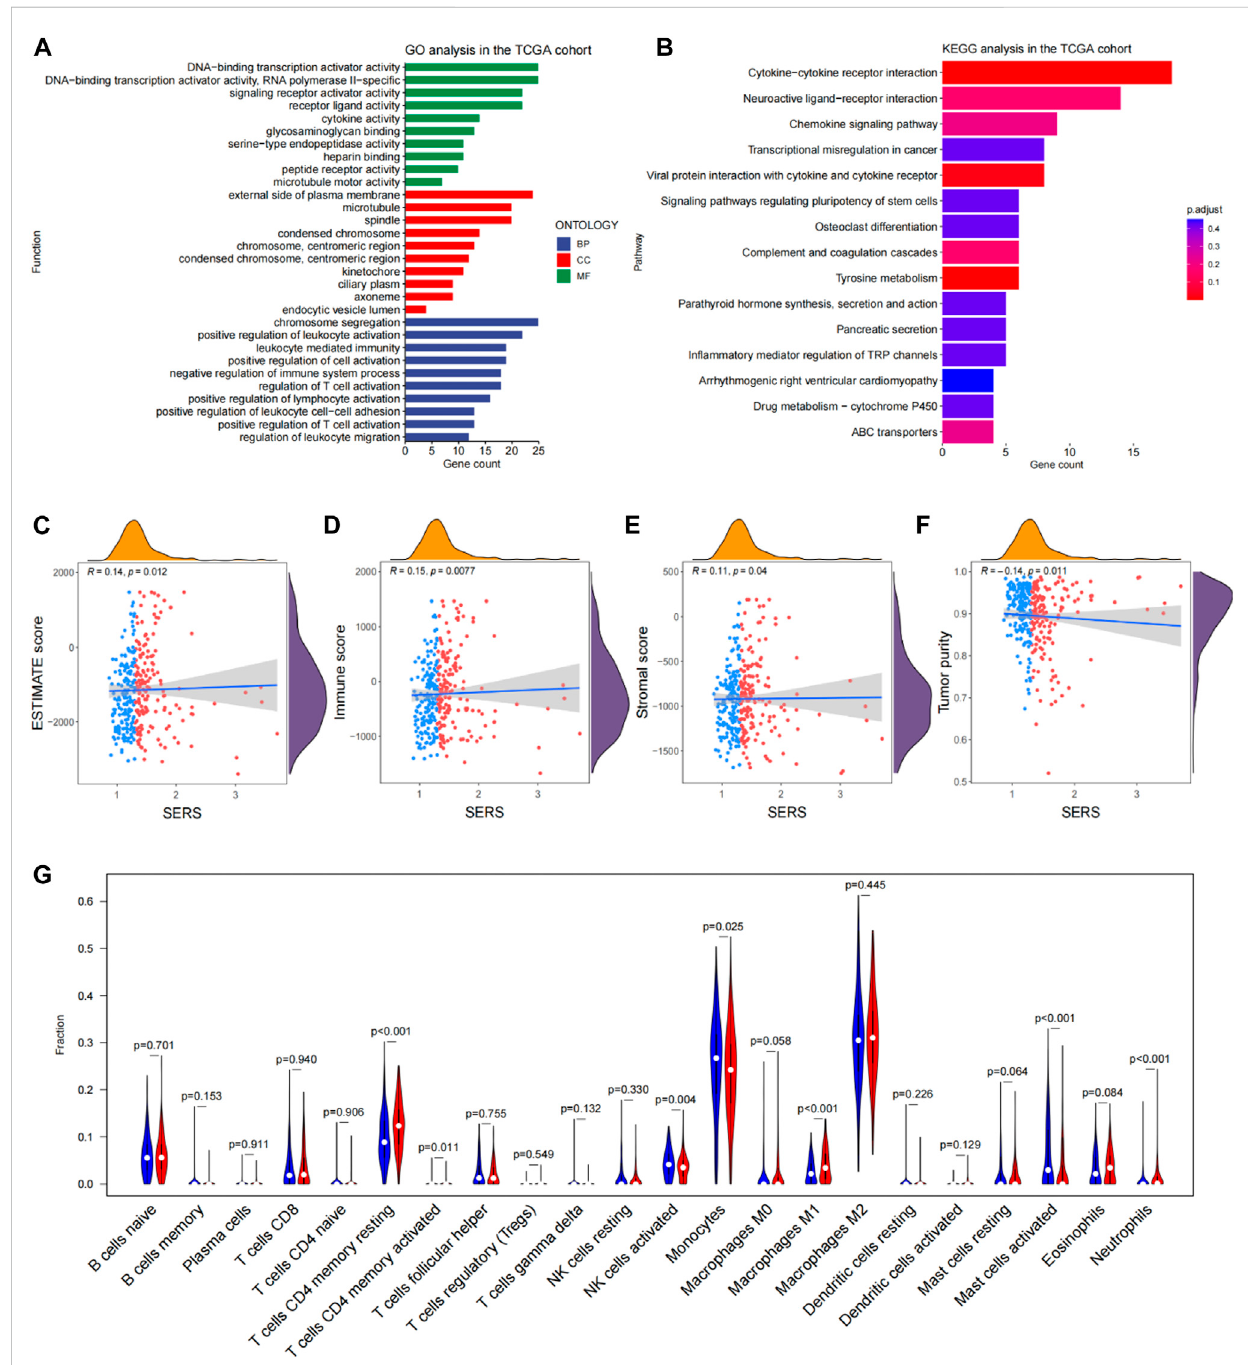
FIGURE 7 Functional enrichment analysis and immune landscape of glioma microenvironmental in the TCGA cohort. (A, B) Go analysis and KEGG analysis in the TCGA cohort. (C – F) Correlation of SERS with immune scores, stromal scores, ESTIMATE scores, tumor purity and SERS. (G) The abundance of 22 immune cells in the high- and low-risk groups. * p < 0.05, ** p < 0.01, *** p < 0.001, and ns No signi fi